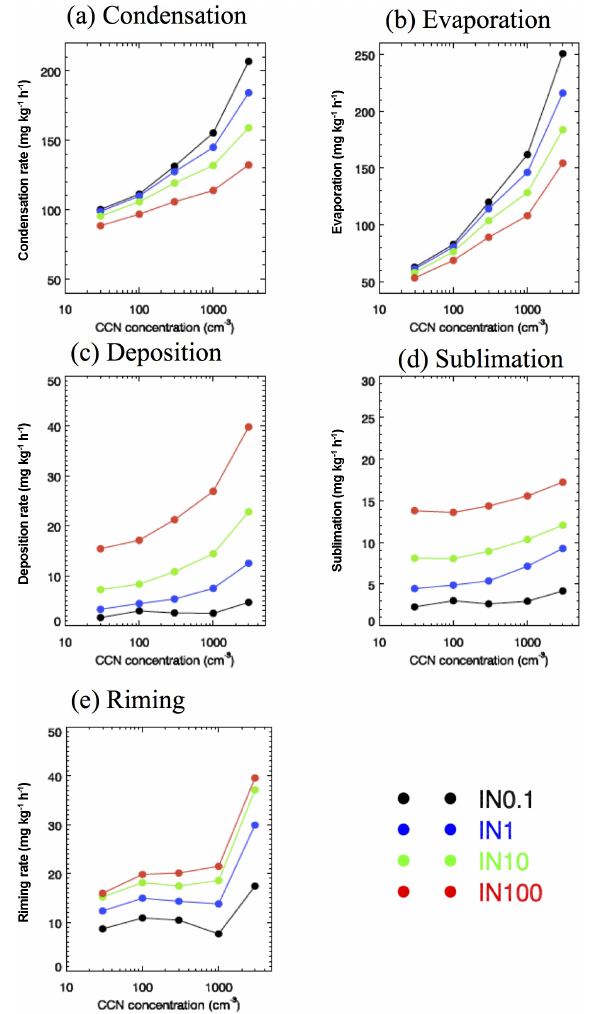
Figure 16. Same as Fig. 4, except for the WMOC.